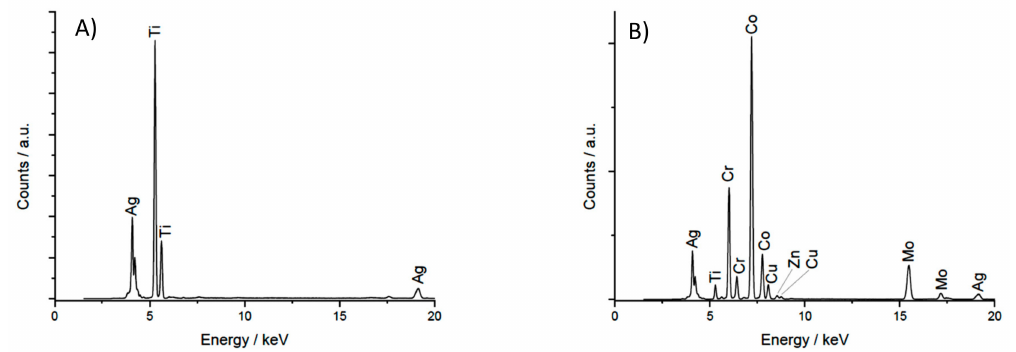
Figure 2. X-ray Fluorescence (XRF) spectra of TiAl6V4-AgNP ( A ) and CoCr-AgNP ( B )